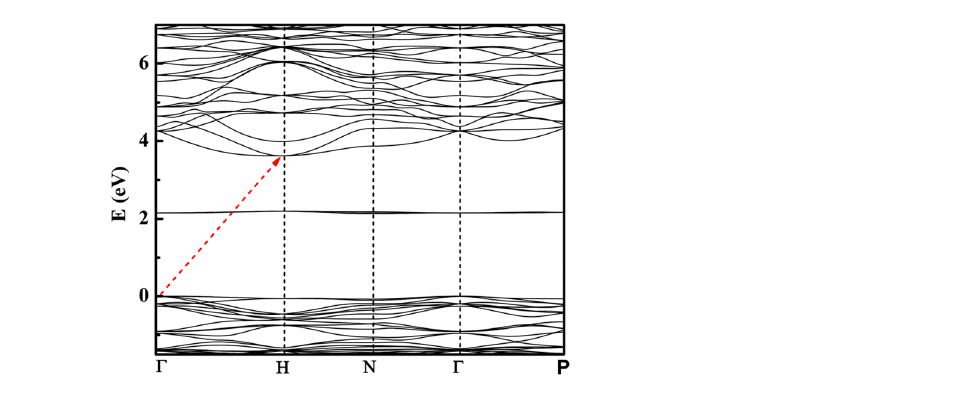
Figure 9. Bandgap energy calculation for sillenite type Bi 12 FeO 20 (cubic) using density functional